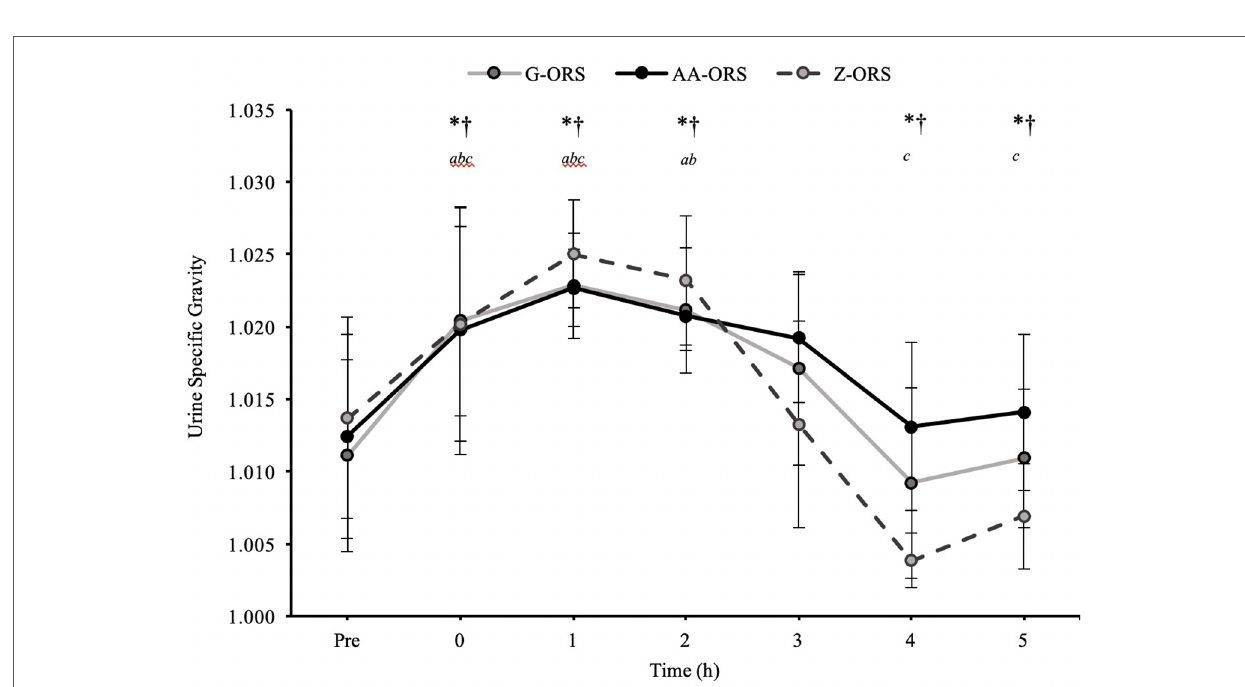
FIGURE 2 Urine speci fi c gravity from baseline (Pre) during the rehydration phase. *, AA-ORS greater vs. Z-ORS (P <0.05); † , G-ORS greater vs. Z-ORS (P <0.05); a , G- ORS different vs. baseline, b , AA-ORS different vs. baseline; c , Z-ORS different vs.